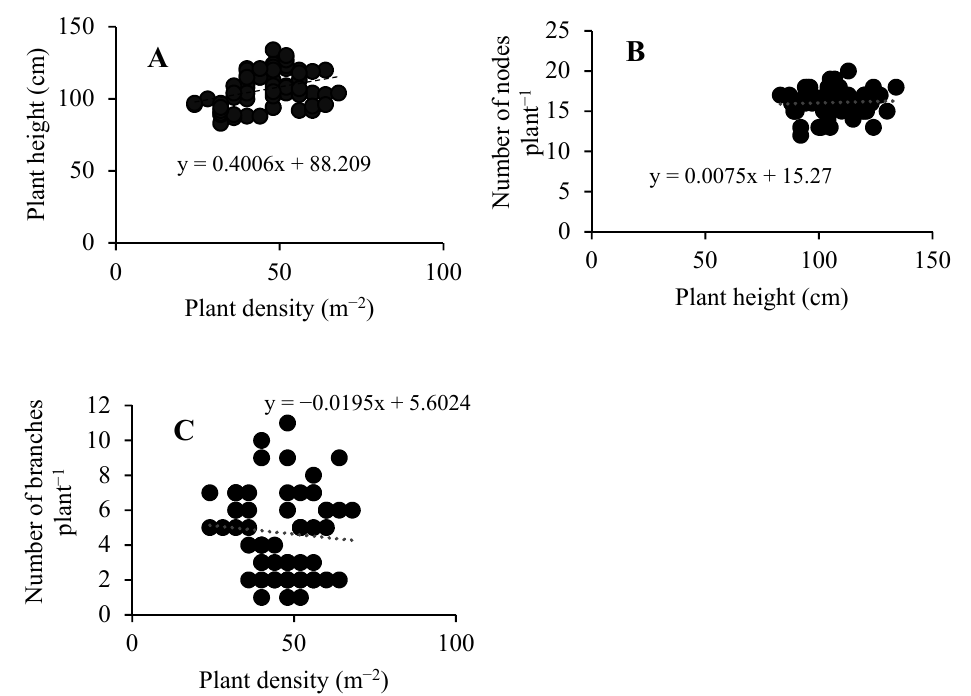
Figure 2. Linear correlations between plant density and plant height ( A ), plant height and number of nodes ( B ), and plant density and number of branches ( C ).